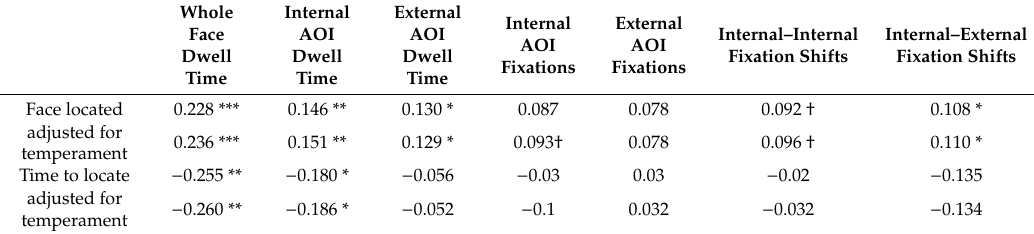
Table 3. Correlations between infant looking behavior during familiarization with ability to locate the face (Spearman rho) and time to locate the face (Pearson) overall and adjusted for temperament.